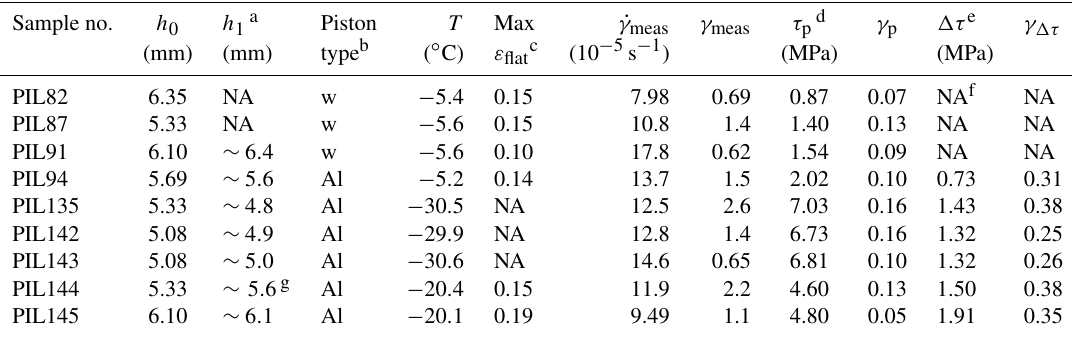
Table 1. Summary of experimental data. Sample no.